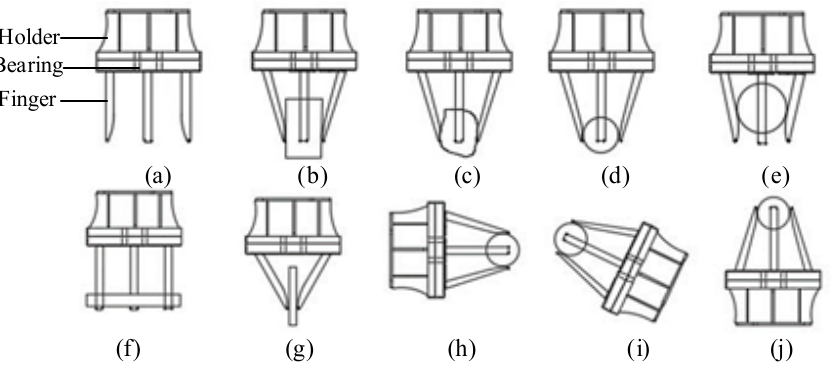
Figure 4. Overview of the gripper grasping objects: ( a ) Gripper structure. ( b ) Box Grab grabbing state. ( c ) Complex object grabbing state. ( d ) Grasp small objects by fingertips. ( e ) The envelope grips large objects. ( f ) cuboid objects transverse grasping state. ( g ) Two finger grasp status. ( h ) Transverse Horizontal grasping status. ( i ) 45 degree grasping status. ( j ) Vertical grasping status.